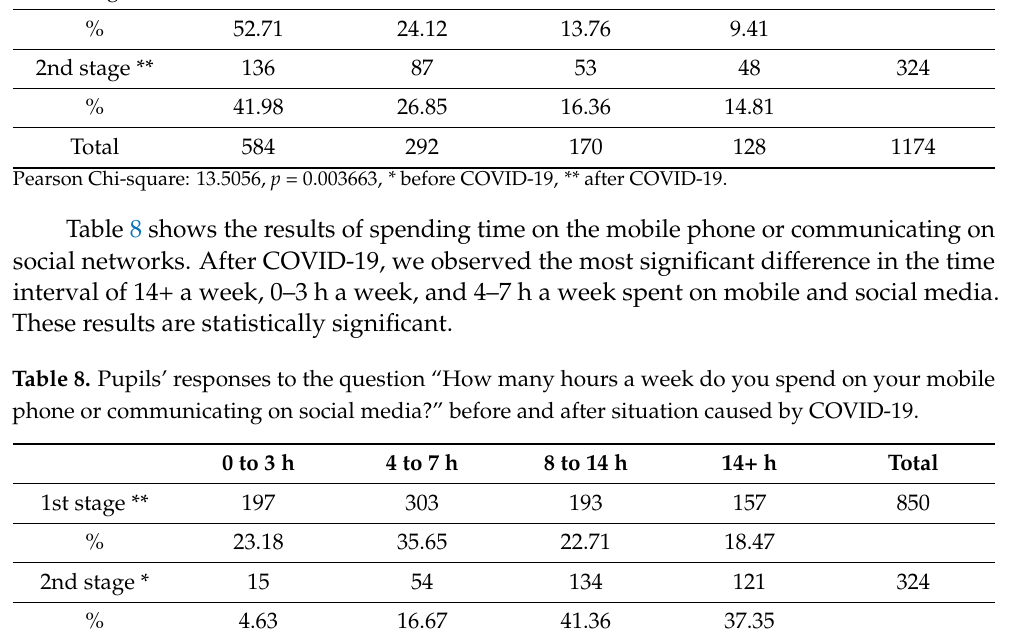
Table 7. Pupils’ responses to the question “How many hours a week do you work on the computer, play computer games or Play Station games?” before and after the situation caused by COVID-19. 0 to 3 h 4 to 7 h 8 to 14 h 14+ h Total 1st stage * 448 205 117 80 850 % 52.71 24.12 13.76 9.41 2nd stage ** 136 87 53 48 324 % 41.98 26.85 16.36 14.81 584 292 170 128 1174